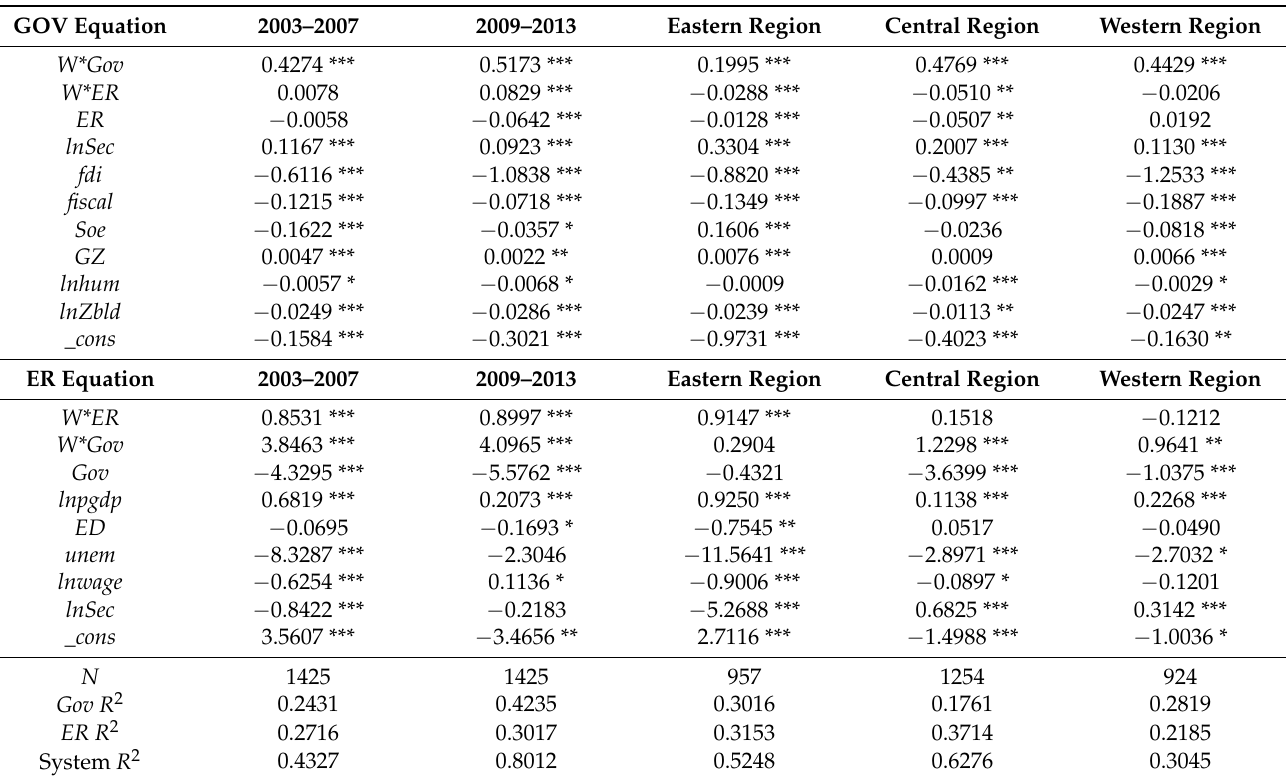
Table 4. Estimated results by stage and by